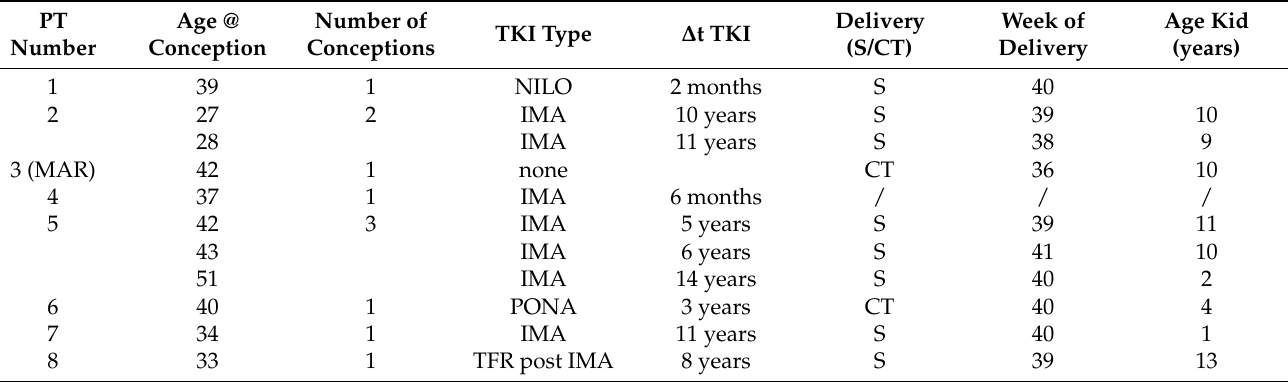
Table 1. Table 1. Conception in male CML